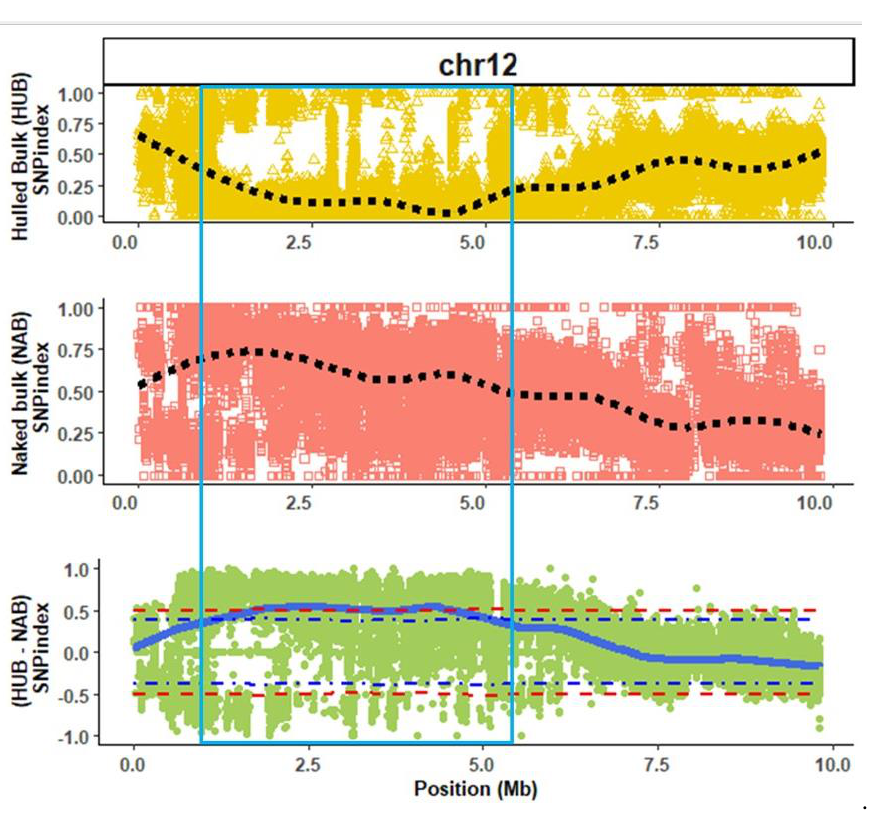
Figure 2. Quantitative trait loci (regions within light-blue square) associated with the hull-less seed phenotype in Kakai cultivar ( Cucurbita pepo ) on chromosome (chr) 12 using Table Gold Acorn as consensus reference genome. The dotted black lines represent smoothed conditional mean of SNP index for hulled (HUB) and hull-less (NAB) bulks, while the solid blue line represents the tricube ∆ SNP for the ∆ SNP index (HUB SNP index − NAB SNP index). The blue and red dotted lines in the ∆ SNP index plot are the 90% and 95% confidence intervals for the regions, respectively.